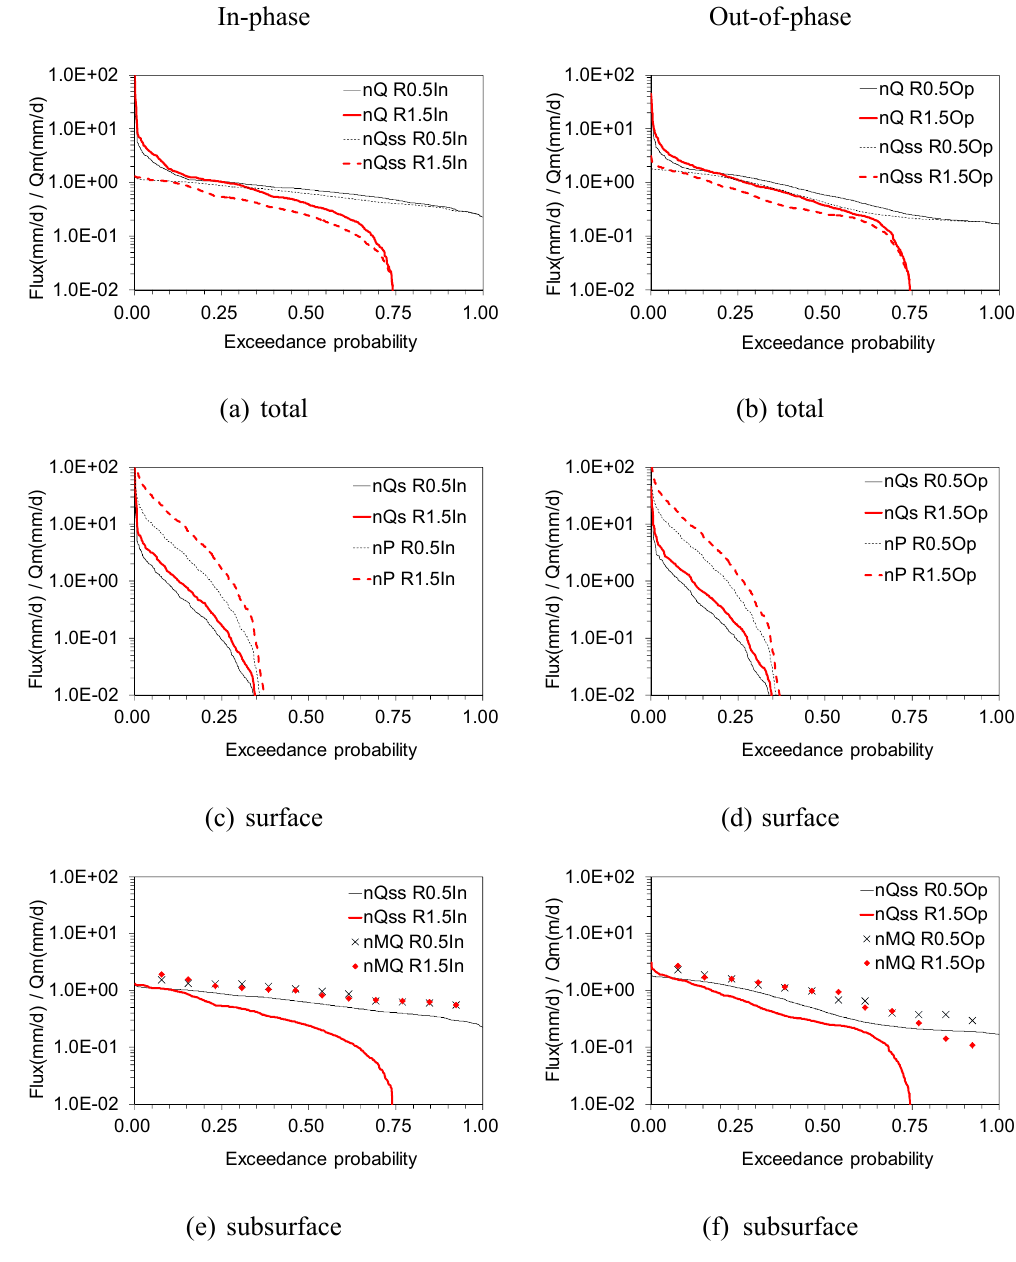
Fig. 3. Effect of dryness index R on the FDC for different types of climatic seasonality: (a) , (b) : Total flow FDC, (c) , (d) :surface flow FDC, (e) , (f) : subsurface flow FDC. (a) , (c) , (e) : seasonal peaks of P and PET are in phase, (b) , (d) , (f) : seasonal peaks of P and PET are of opposite phase. The numbers after R are dryness indices. In each panels, “In” and “Op” indicates P and PET are in-phase and of out-of-phase, respectively. Q m is mean annual daily flow (mmd − 1 ). “ nMQ ” refers to FDC associated with the regime curve – ensemble averaged mean within-year daily variation normalized by mean annual daily flow Q m . Default value of soil type is silty loam, soil depth is 8m, and the topographic gradient is